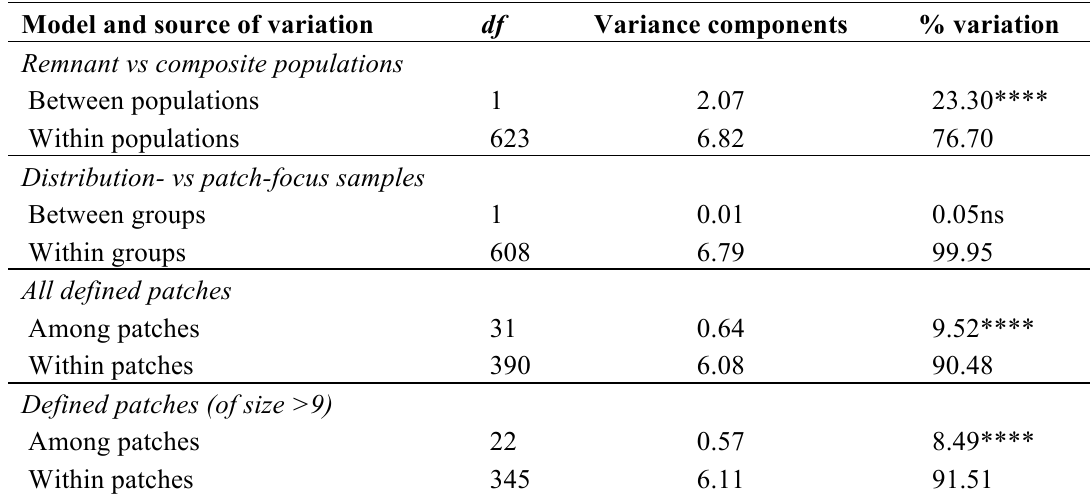
Table 2. The results for the analysis of molecular variance of 625 assayed plants of hairy prairie-clover with four models of genetic